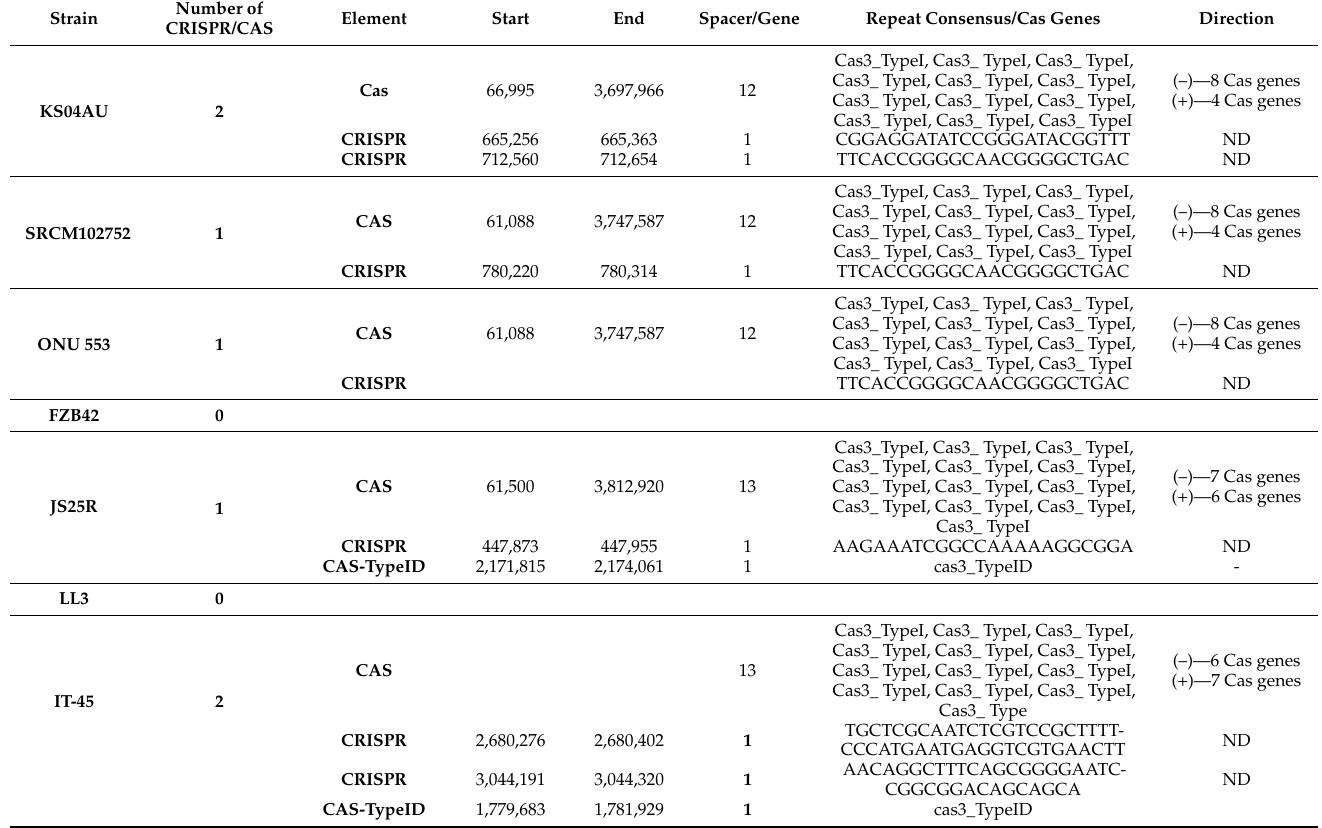
Table 9. Comparison of the CRISPR elements in Bacillus velezensis and amyloliquefaciens